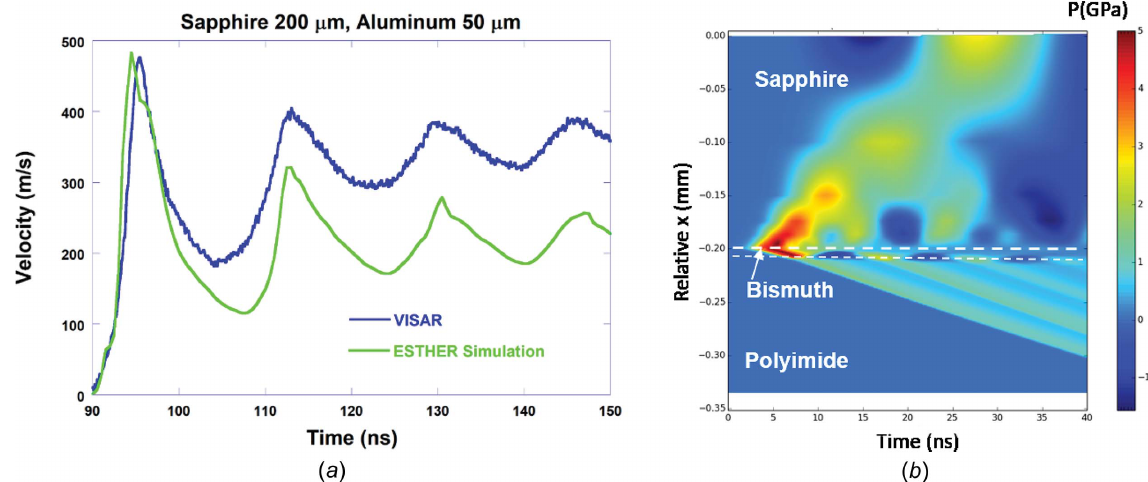
Figure 13 ( a ) Comparison of the VISAR measurement and the ESTHER simulation of a target made of a window of 200 m m of sapphire and 50 m m of Al. ( b ) The pressure map of a Bi target (sapphire/Bi/polyimide) when the same simulation parameters are applied. The used EOS in the simulations are: SESAME 3720 for Al, SESAME 7411 for sapphire and BLF for